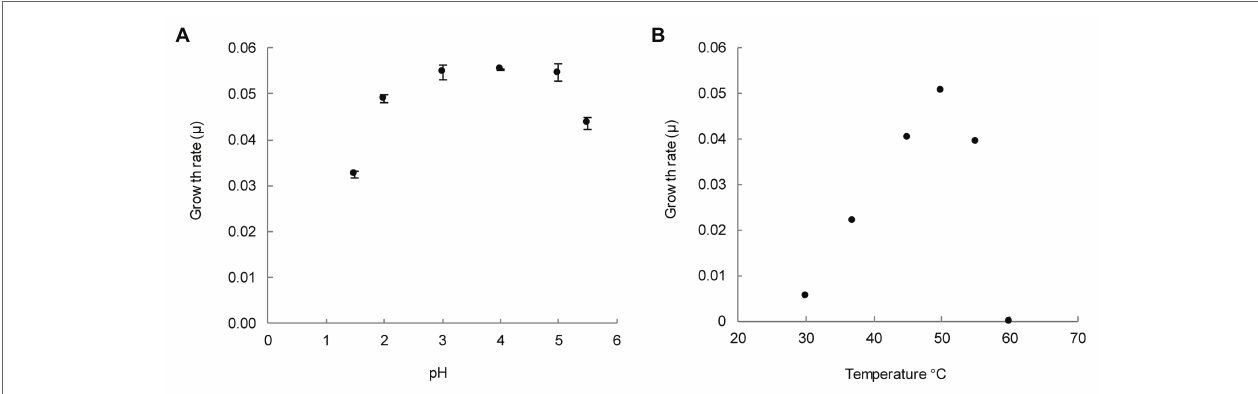
FIGURE 3 | pH and temperature range for the growth of M. thermophilum AP8. (A) Growth rate per hour ( μ ) for six different pH values. Growth rates were determined for exponentially growing cultures for which pH remained constant. The error is expressed as the standard deviation over three biological replicates. (B) Growth rate per hour ( μ ) for temperatures from 30 to 60 ° C. Maximum growth rate ( μ max ) was observed at 50 ° C ( μ = 0.05 h −1 ). The error is expressed as the SD over three biological replicates. Where not visible, error bars are smaller than the